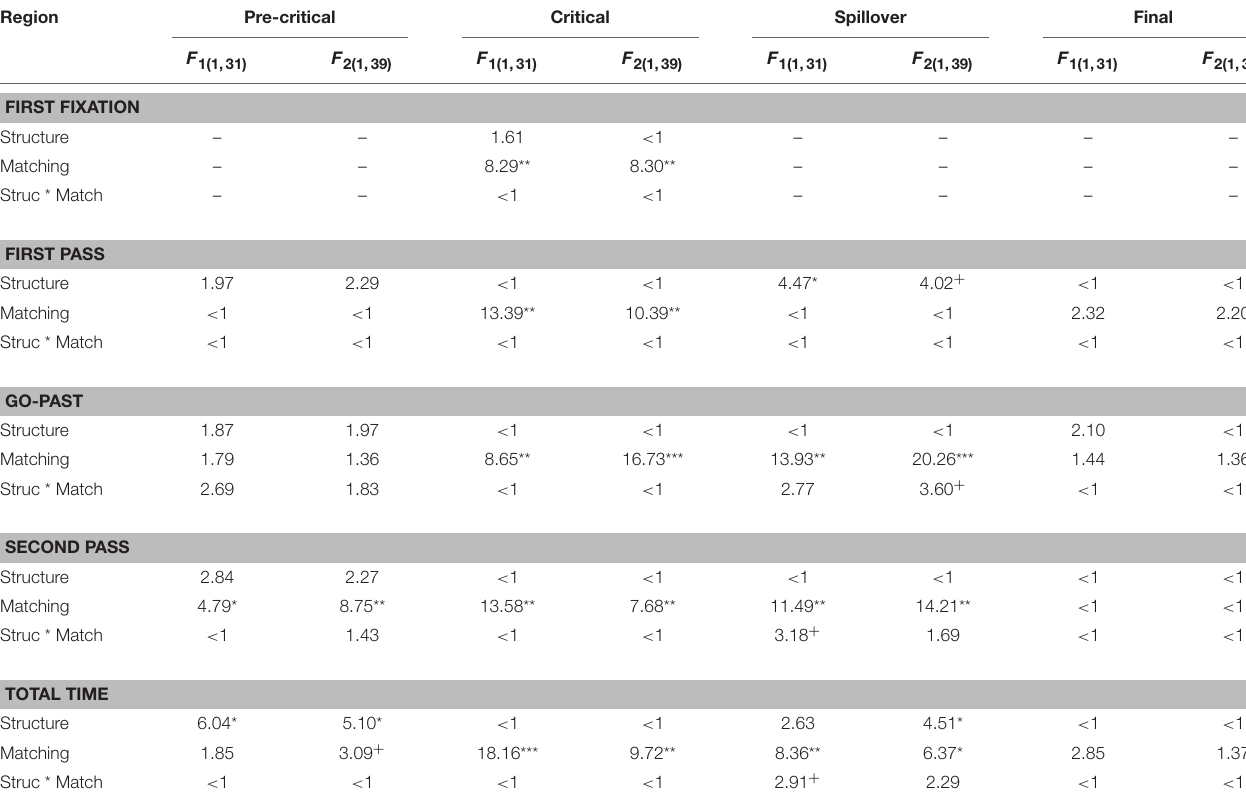
TABLE 4 | Anova results for Experiment 2 ( + p < 0 . 1 ; * p < 0 . 05 ; ** p < 0 . 01 ; *** p < 0 . 001 ).